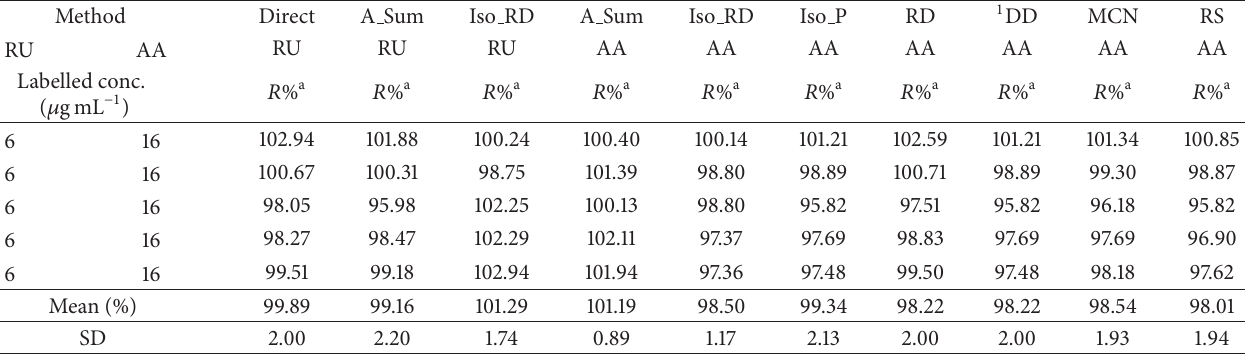
Table 2: Determination of AA and RU in tablets (Ruta C 60) batch number